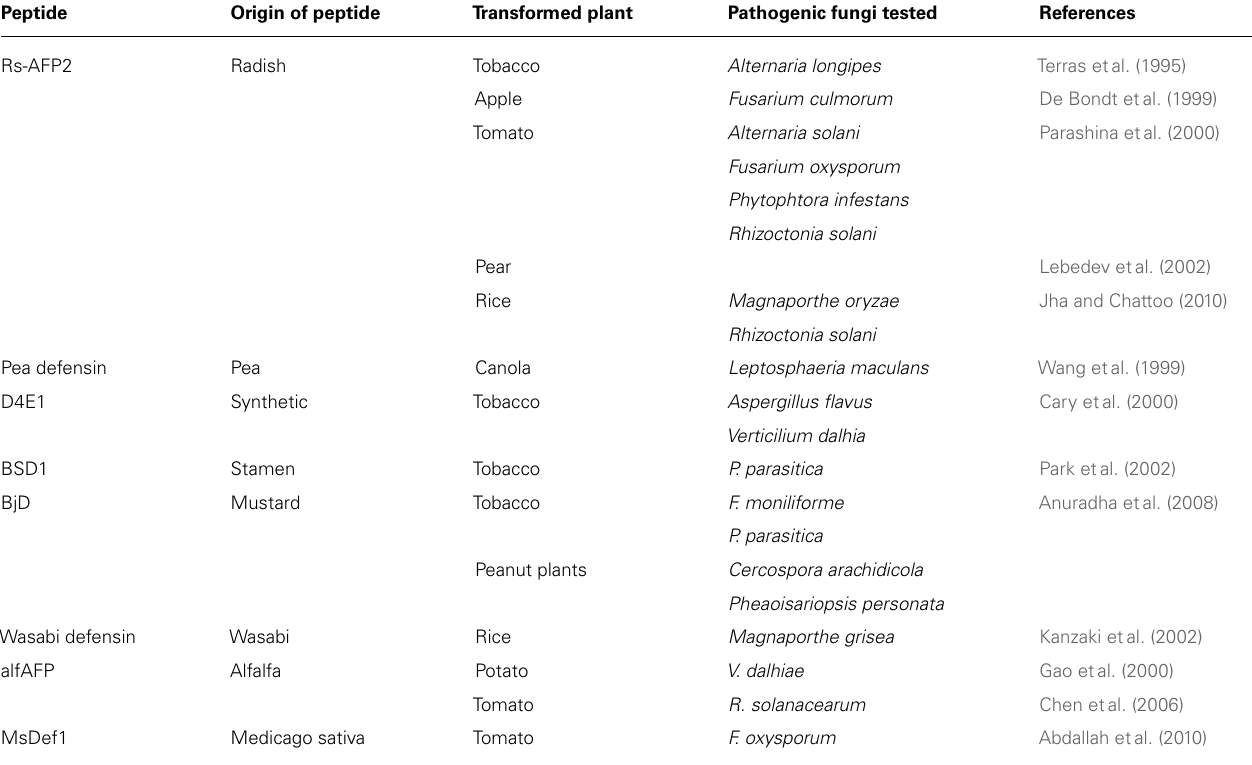
Table 2 |Antifungal defensins from plant sources used for transformation into foreign